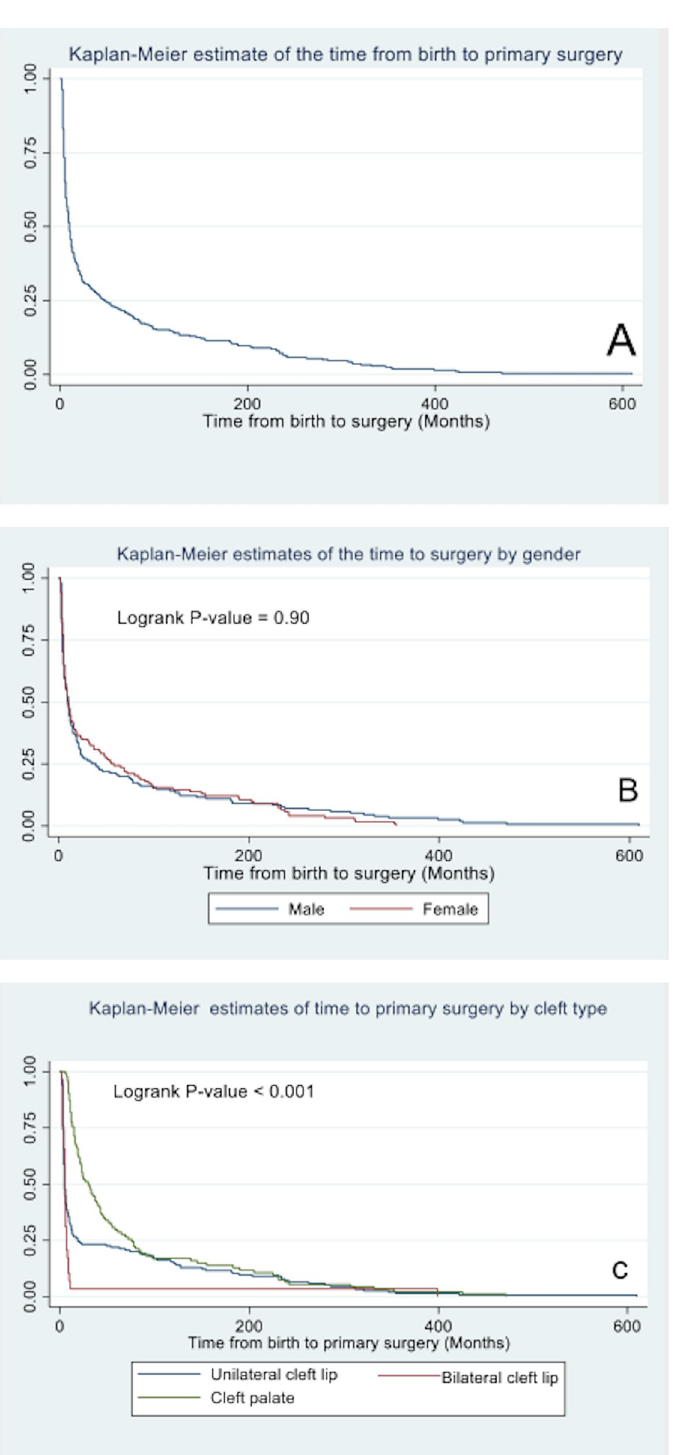
Fig 5. A. Kaplan Meir plot of the time to cleft surgeries. B. Kaplan Meir plot of the time to cleft surgeries stratified by gender. C. Kaplan Meir plot of the time to cleft surgeries stratified by type of cleft defect.